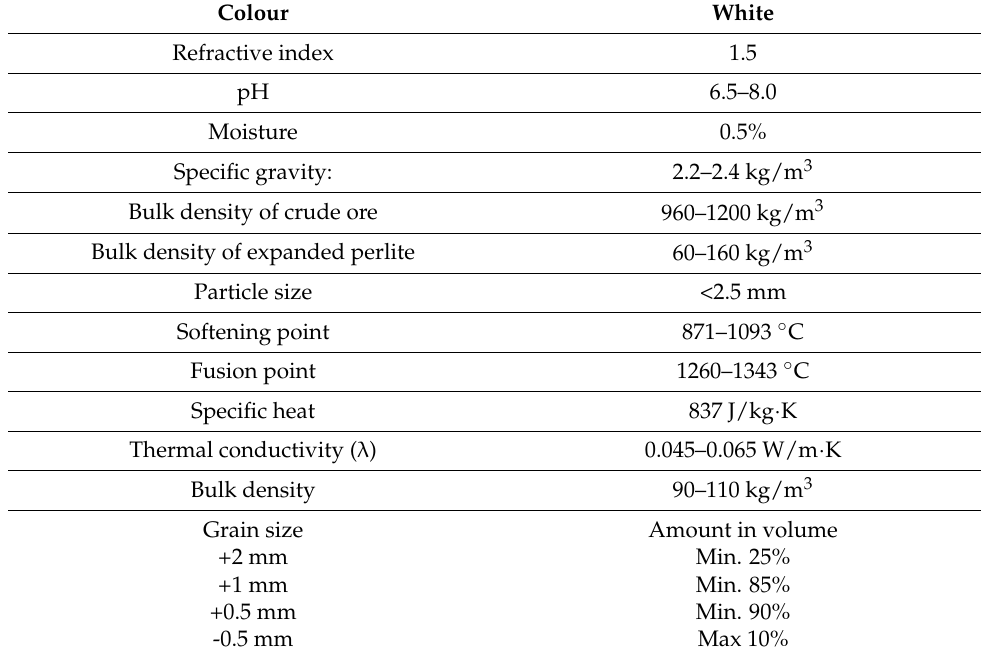
Table 1. Physical characteristics of perlite used in the production of